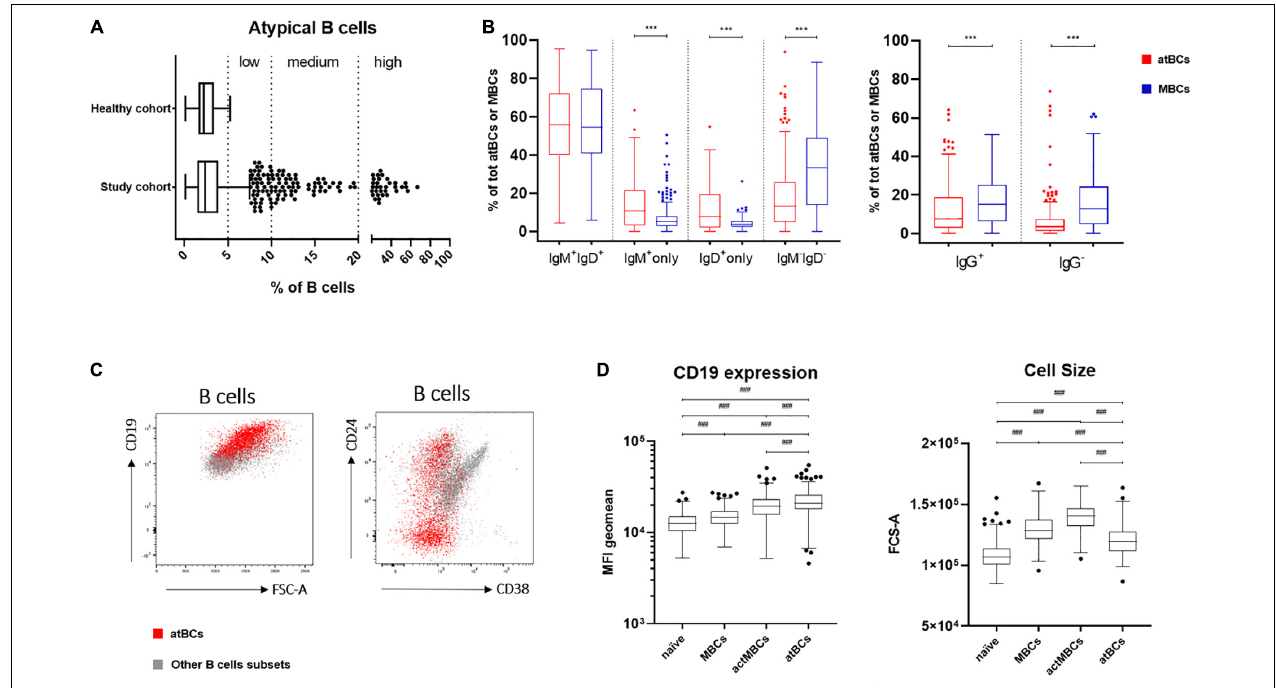
FIGURE 2 | atBCs features: distribution, immunoglobulin isotypes and specific immunophenotype. (A) Box plots showing distribution of atBCs in the study and the healthy cohorts. Midline, lower and upper limits represent median, the first and the third quartiles, respectively. Whiskers indicate lower quartile –1.5 × IQR (interquartile range) and upper quartile + 1.5 × IQR. Outliers are shown as dots. Dotted lines separate atBCs based on percentages: ≤ 5%, > 5%, and ≤ 10% (low increase), > 10% and ≤ 20% (medium increase), > 20% (high increase). (B) Box plots showing the comparisons of IgM, IgD, or IgG expressing B cells between atBC and classical MBC subsets. Only samples with atBCs > 5% are represented. (C) FACS dot plots of a representative sample with DiGeorge syndrome showing atBCs (in red) and other B-cell subsets (in light gray) based on expression of CD24, CD38, and CD19 and FSC-A. (D) Comparison by box plots of CD19 MFI (mean fluorescence intensity) levels and FCS-A values among naïve, MBCs, actMBCs, and atBCs. Only samples with atBCs > 5% are represented. Statistical significances were determined using unpaired two-tailed Mann–Whitney U -tests or Kruskal–Wallis test with adjusted p -value at 0.004167, ∗∗∗ p < 0.001; ### p <